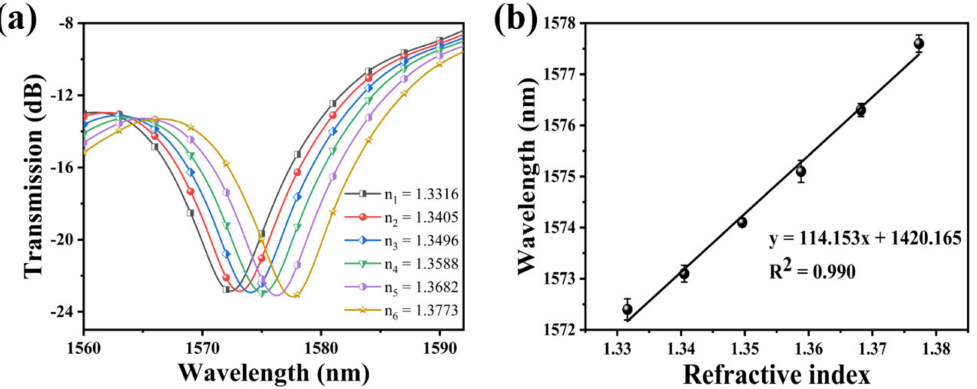
Figure 5. ( a ) Variation of the resonance wavelength of the bare SNS sensor with different RI; ( b ) the relationship between wavelength variation and the